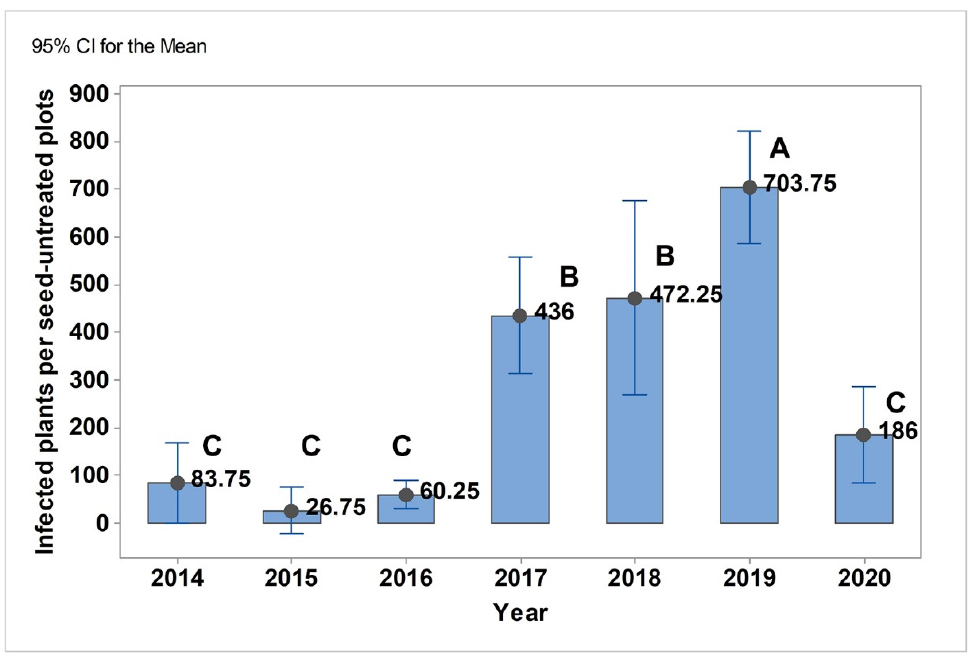
Figure 1. Joined occurrence of U. nuda and P. graminea in seed-untreated plots in 2014–2020. Means that do not share a letter are significantly different that do not share a letter are significantly